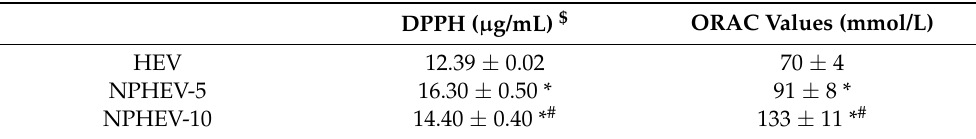
Table 2. HEV and NPHEV antioxidant action in DPPH and ORAC